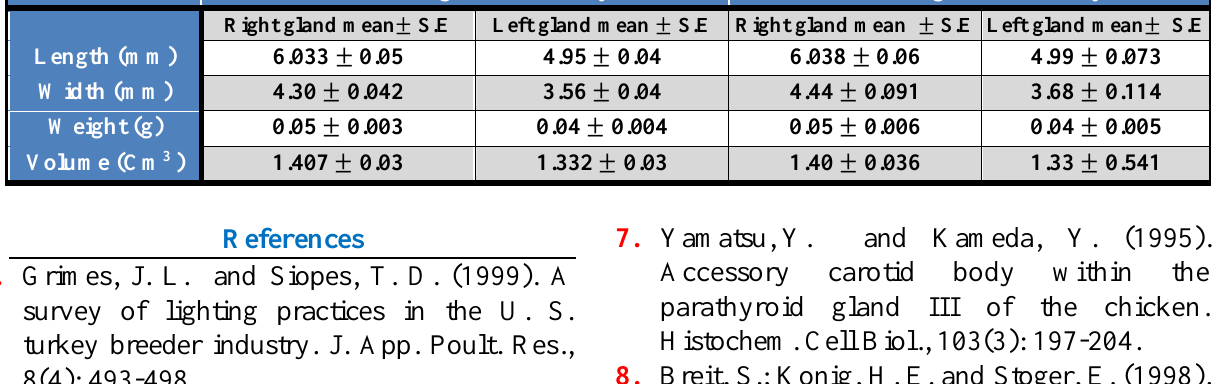
Ultimobranchial gland in Turkey Female Ultimobranchial gland in Turkey Male Parameters